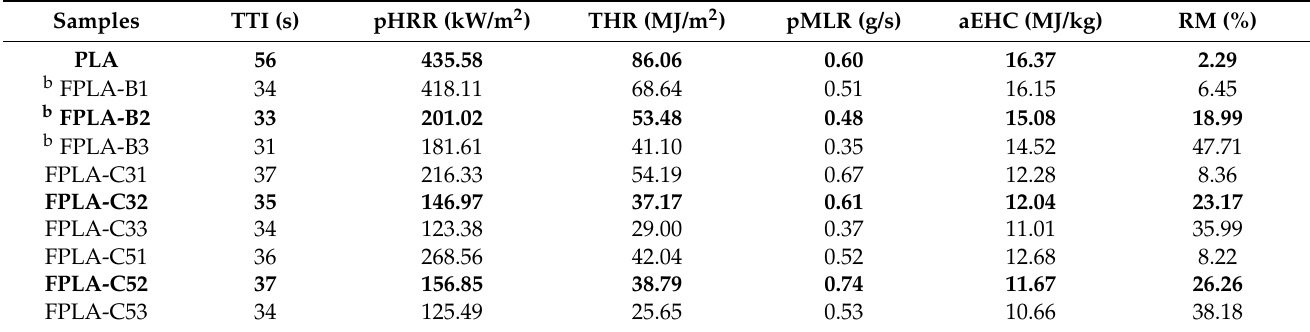
Table 7. a Cone calorimeter results for each sample at 35 kW/m 2 .